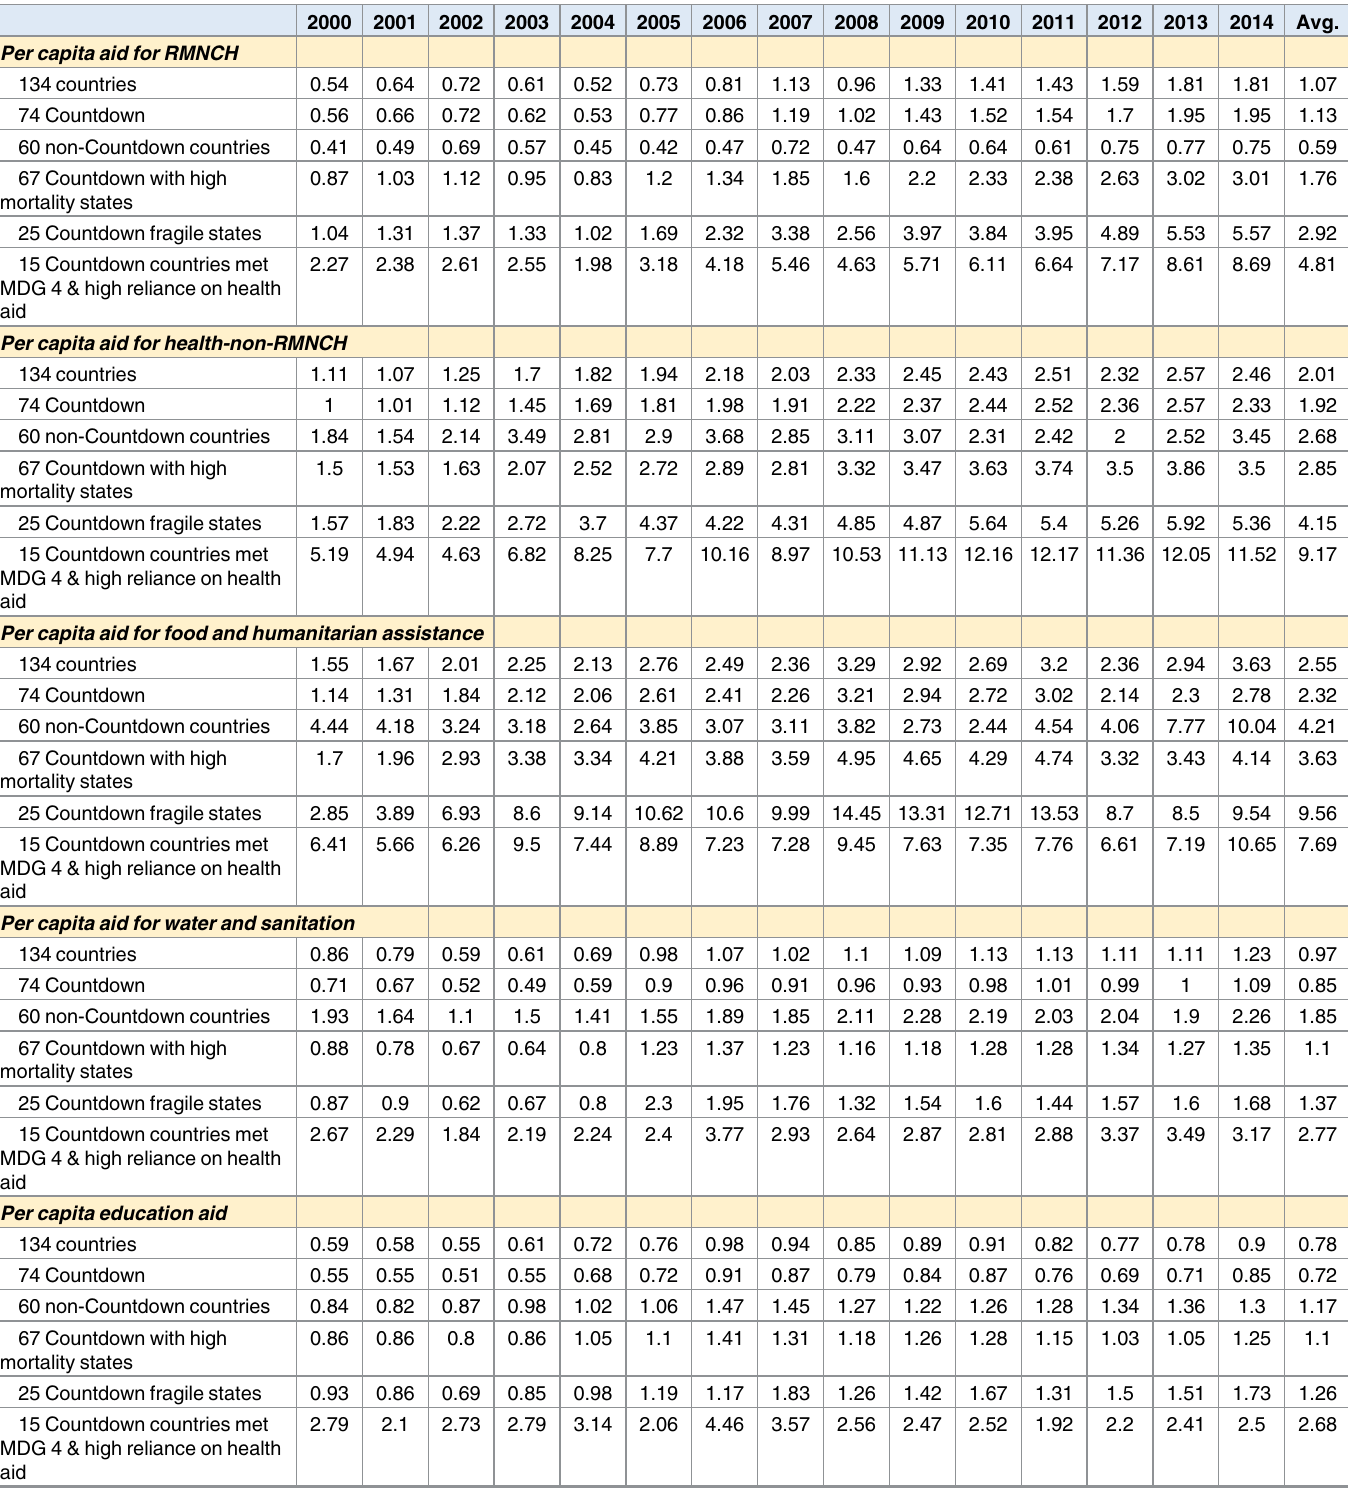
Table 3. Upper-bound annual per capita disbursements to RMNCH, food and humanitarian assistance, education, and water/sanitation by differ- ent country groups,